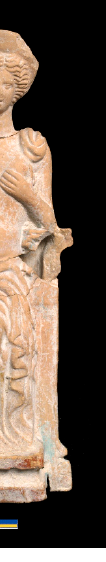
Figure 4. Terracotta figurine of semi-naked Aphrodite resting on a pillar from Amathous, AM 949, Limassol District Museum. Image© The Department of Antiquities, Cyprus (courtesy of the director).